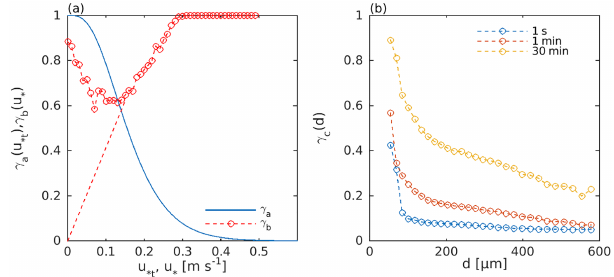
Figure 6. (a) Saltation intermittency function γ a (u ∗ t ) and γ b (u ∗ ) . See text for more details. (b) γ c as a function of particle size for Q 1s , Q 1min and Q 30min .